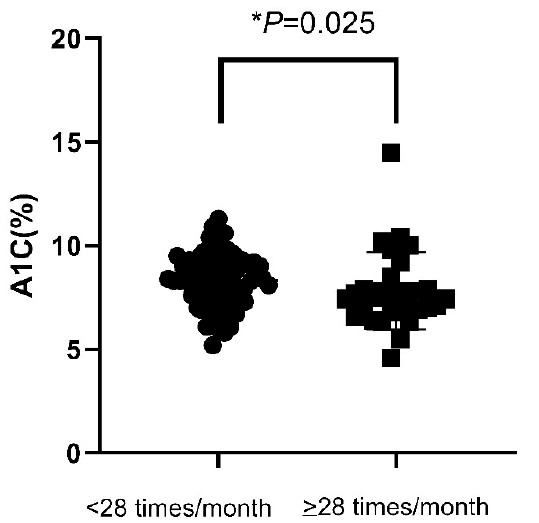
Figure 1. A1C value in insulin-treated patients according to the frequency of SMBG (<28 or ≥ 28 measure- ments a month). A1C—hemoglobin A1C; SMBG—self-monitoring of blood glucose. * p < 0.05.